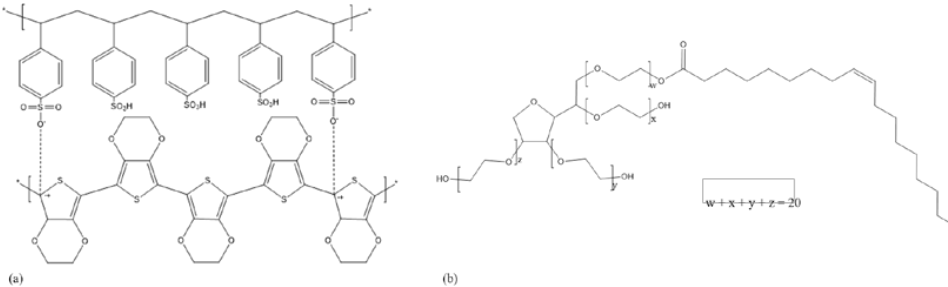
Figure 1. Chemical structures of ( a ) PEDOT:PSS and ( b ) Tween 80.